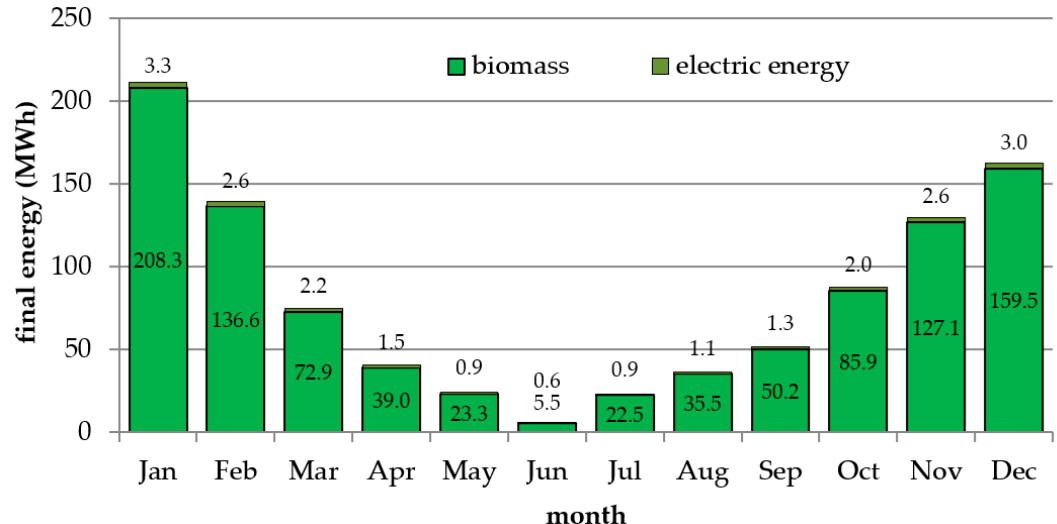
Figure 4. Monthly sums of final energy demand used for heating and auxiliary electricity; fuel—biomass (scenarios 3 and 4).